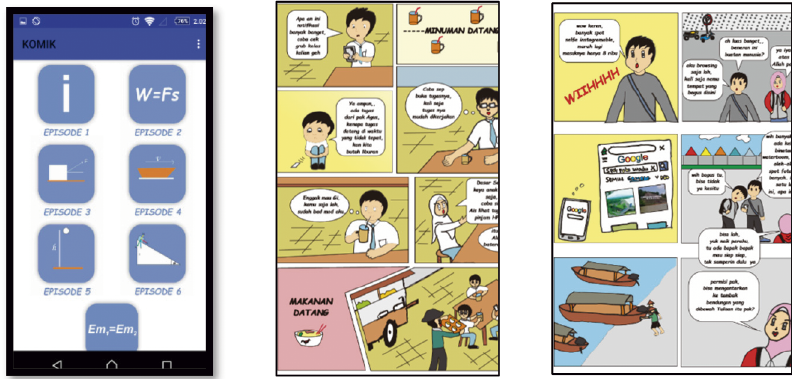
Figure 4. Display of Android-based comic media of Gajah Mungkur Dam